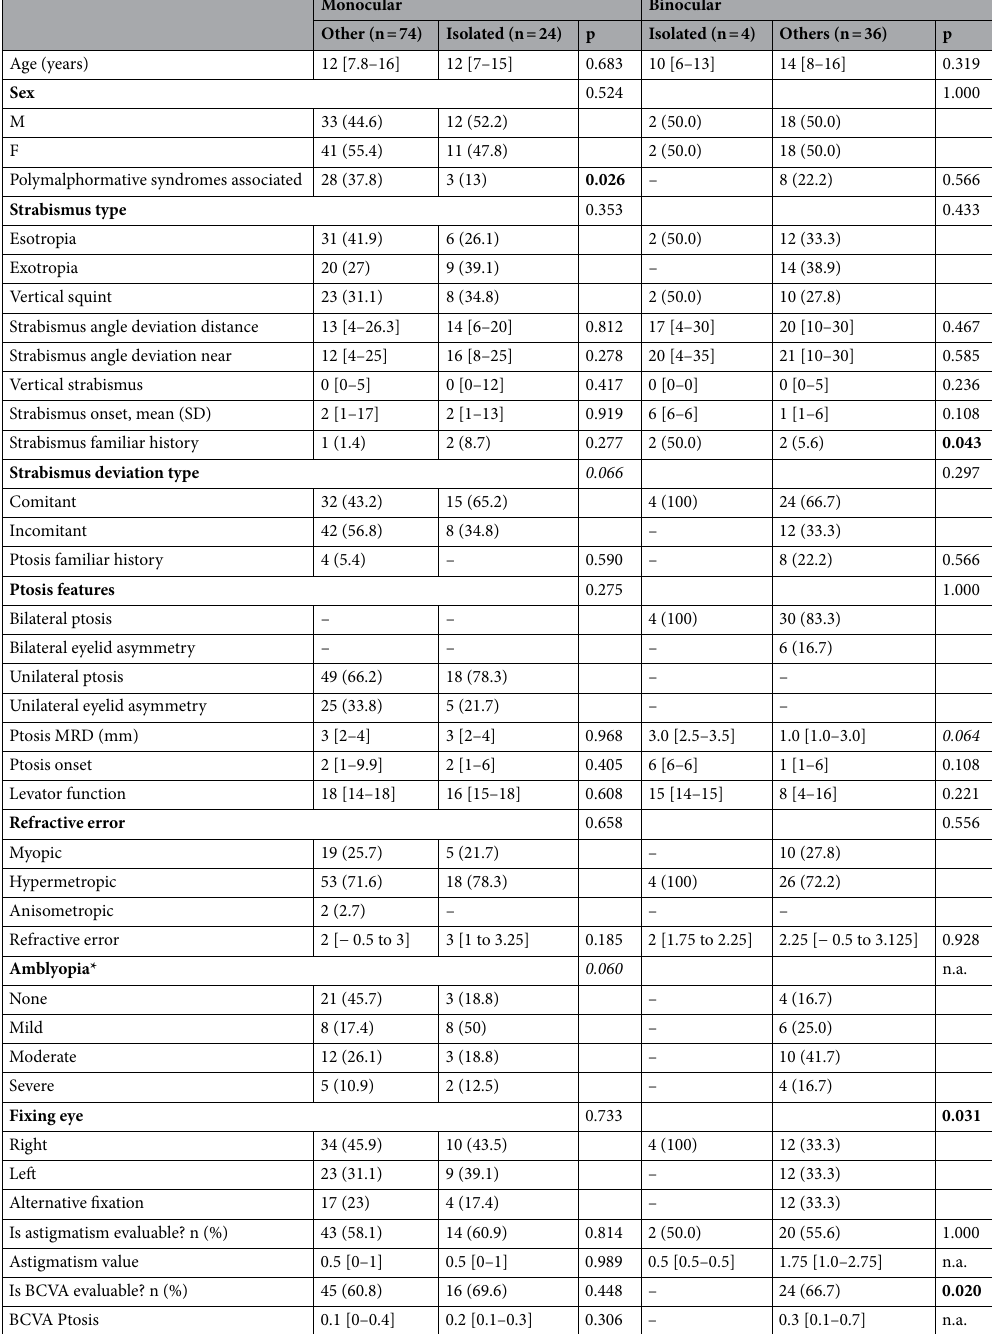
Table 5. Association between disease categories and general and clinical characteristics in the study cohort, according to patients’ subgroups (n = 137). M male, F female, MRD margin reflex distance, BCVA best corrected visual acuity. *Amblyopia was analysed on the subgroup of patients for which information was available. Significant data are in bold, suggestive p-values in